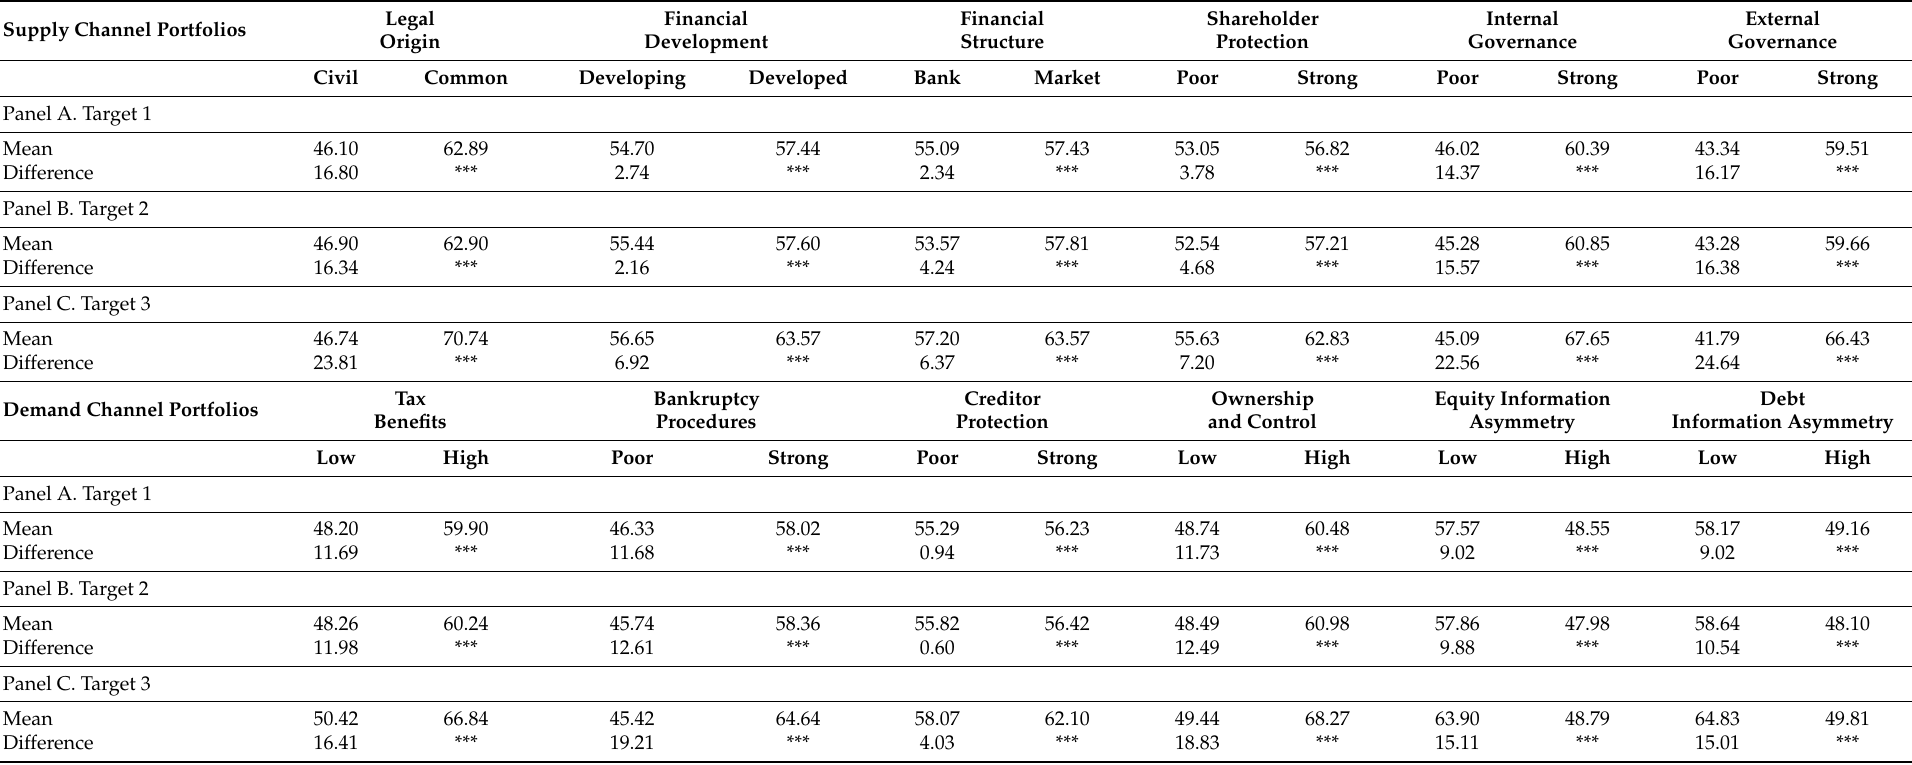
Table 7. The impact of institutions on target capital structure using the composition of